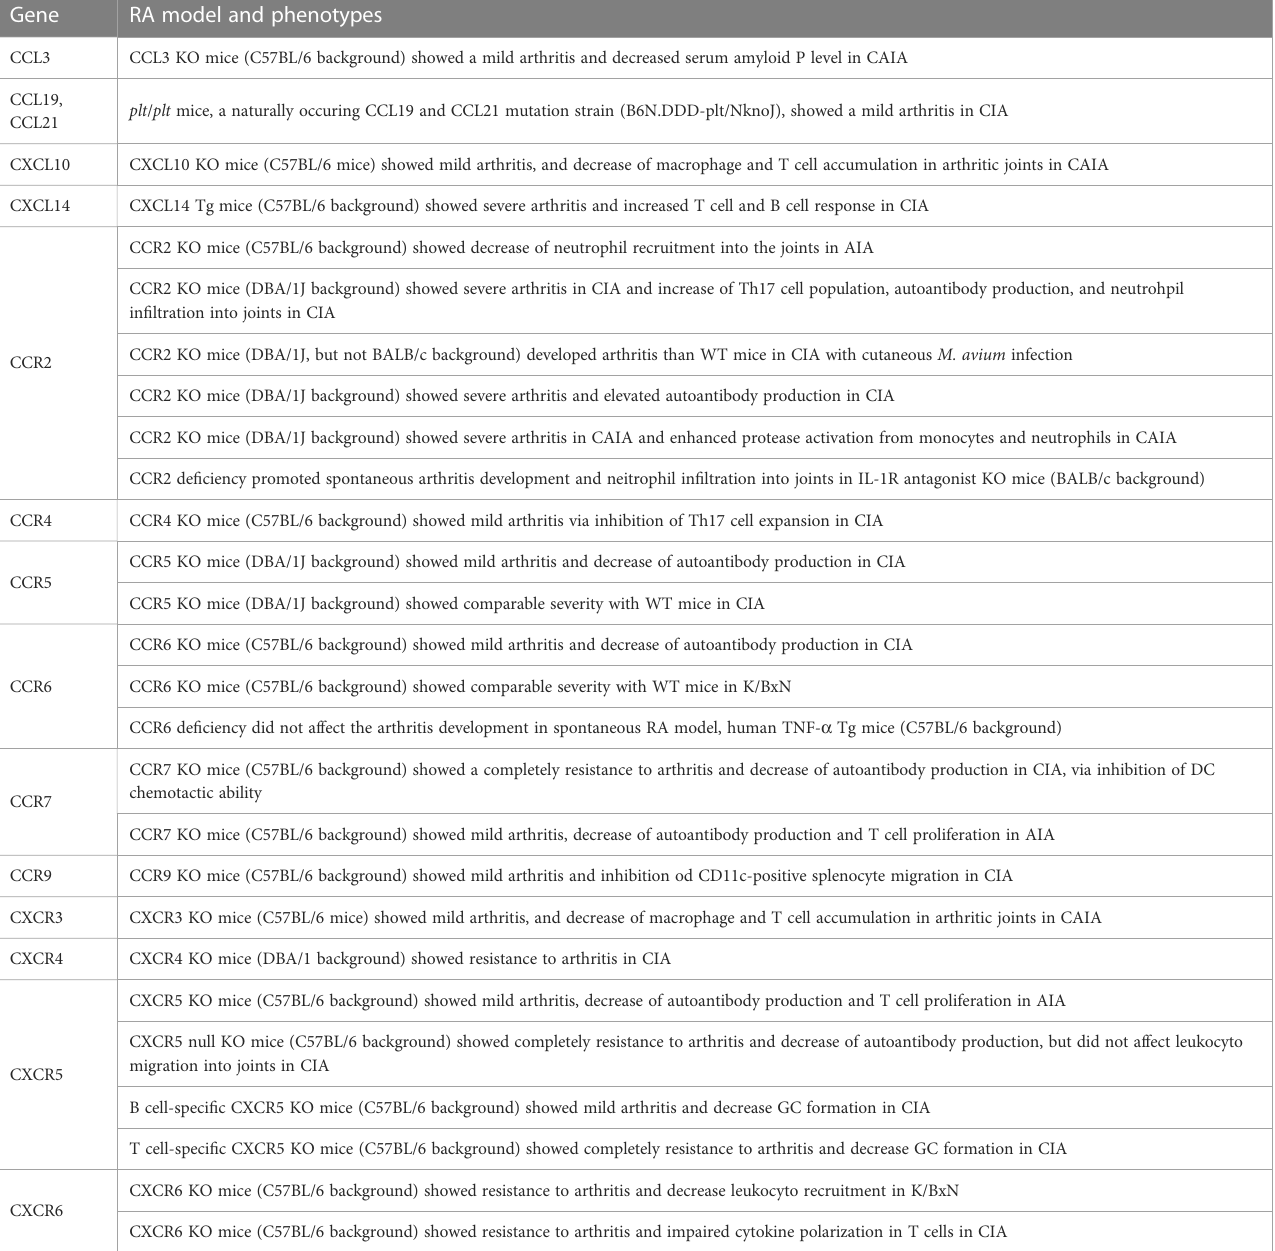
TABLE 4 The phenotypes of chemokine ligands and receptors gene-modi fi ed mice in RA